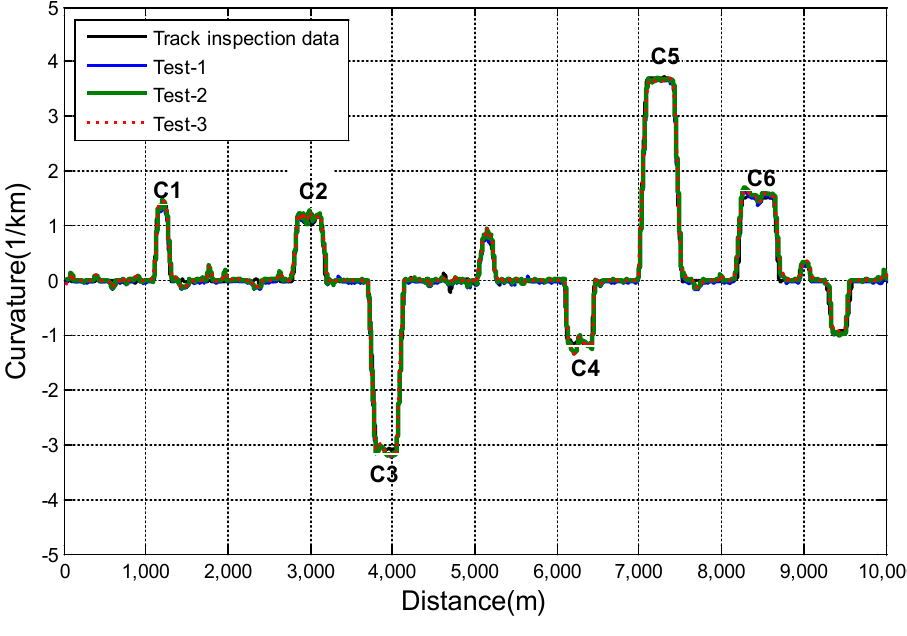
Figure 15. Curvature test result.